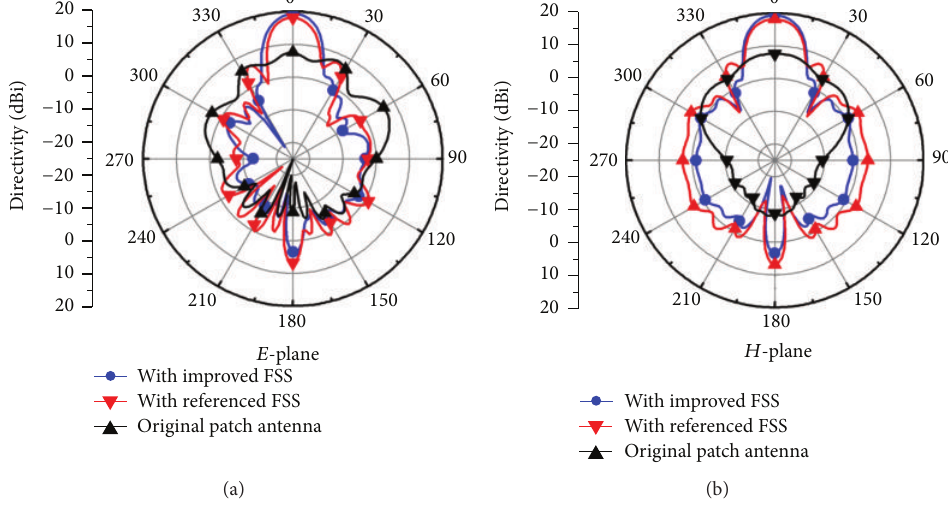
Figure 8: Comparison of directivities patterns of different FSS superstrates, (a) 𝐸 -plane and (b) 𝐻 -plane.